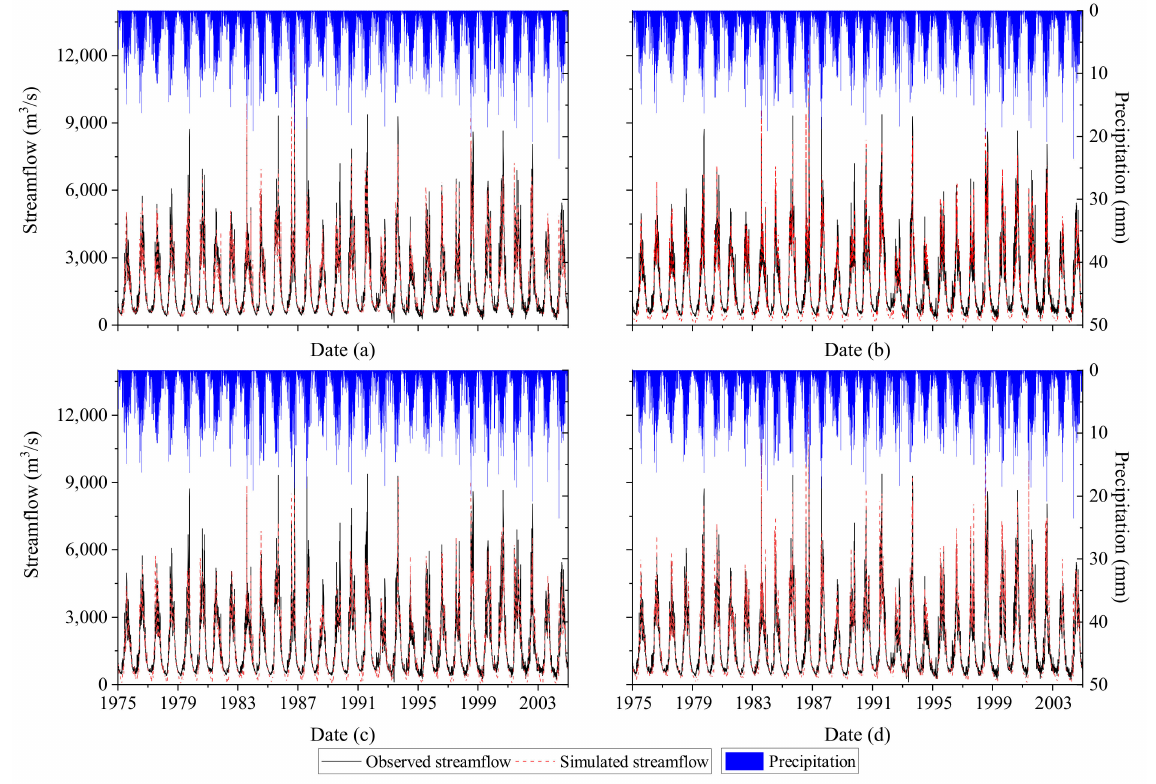
Figure 3. Comparison of best simulation results using the SUFI-2 ( a ), ParaSol ( b ), GLUE ( c ), and PSO ( d ) methods compared against the observed streamflow in the calibration (1975 to 1989) and validation (1990 to 2004) periods. The blue histogram shows the average daily precipitation in the Lancang River (LR)